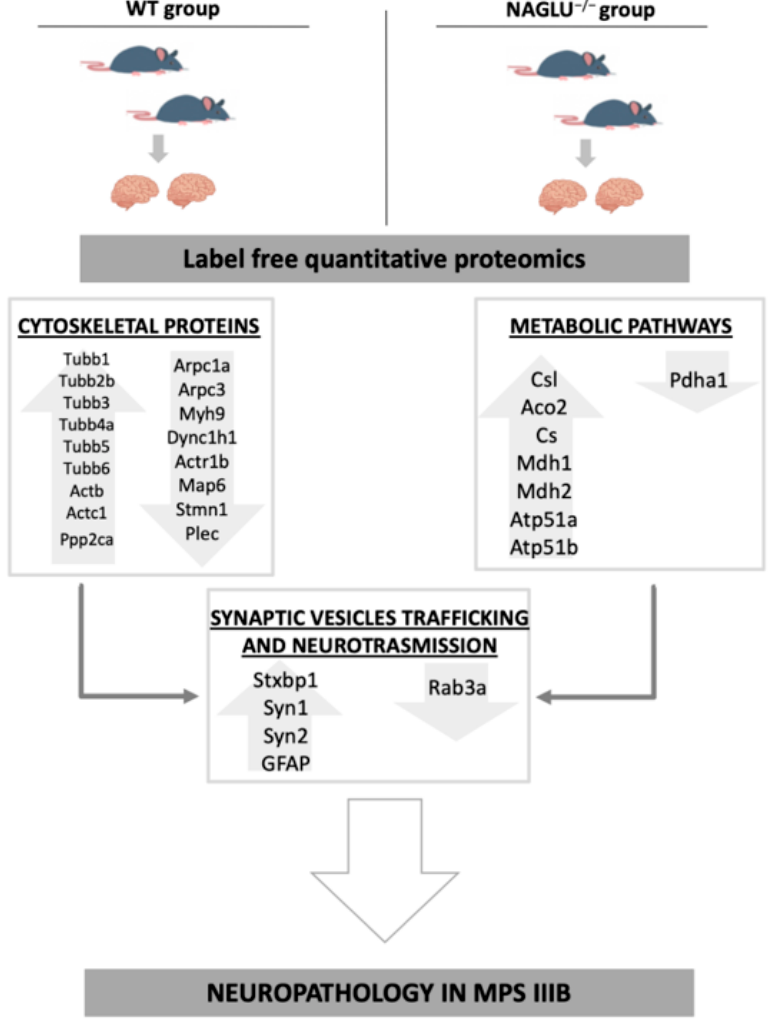
Figure 7. Representation of the main proteomic modifications induced by NAGLU deletion in murine brains. Dysregulation of cytoskeleton associated proteins and the energy metabolism-involved proteins may contribute to impair the lysosomal membrane trafficking pathway linked to the pathogenesis of neuropathy in MPS IIIB disease. Both altered pathways are relevant to preserve brain homeostasis and could be responsible for an impairment of synaptic vesicle formation and activity in the MPS IIIB mouse brain.